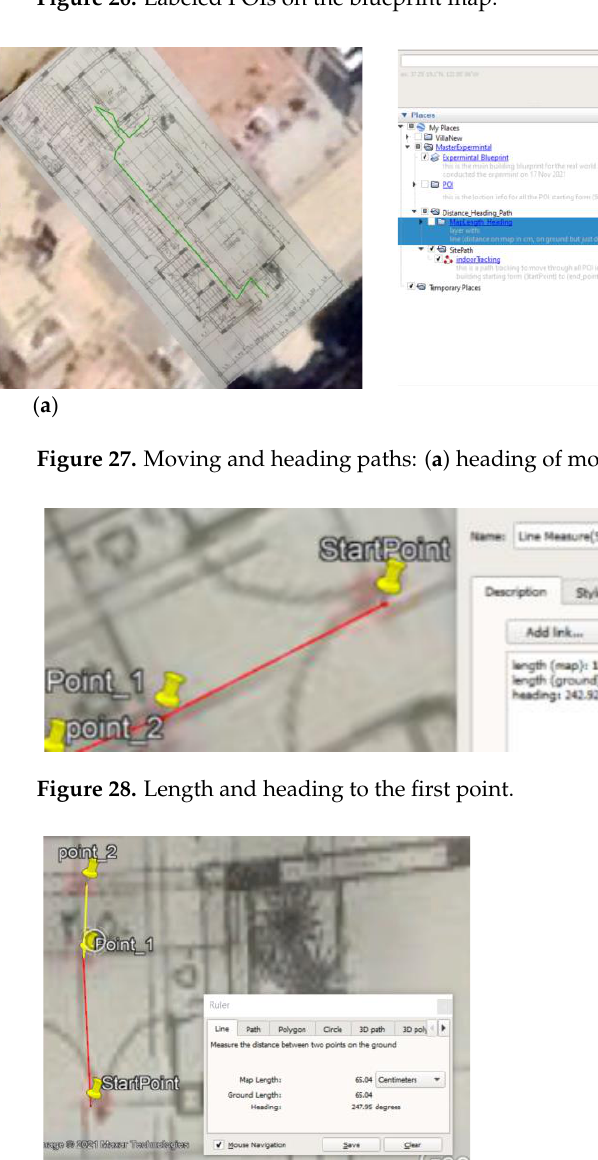
Figure 30. Length and heading to point_3. Figure 31. Length and heading to point_4.